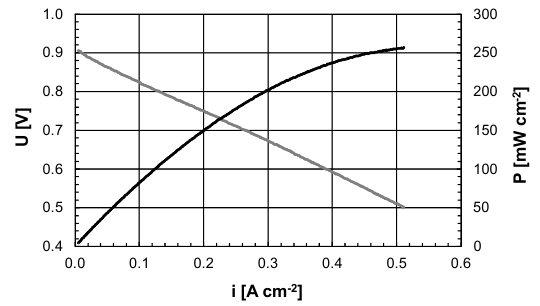
S on the SOFC cell performance 2 at 250 mA cm -2 current density at 800°C for the fuel (50%H /%50N ) humidified with 3% H O. 2 2 2